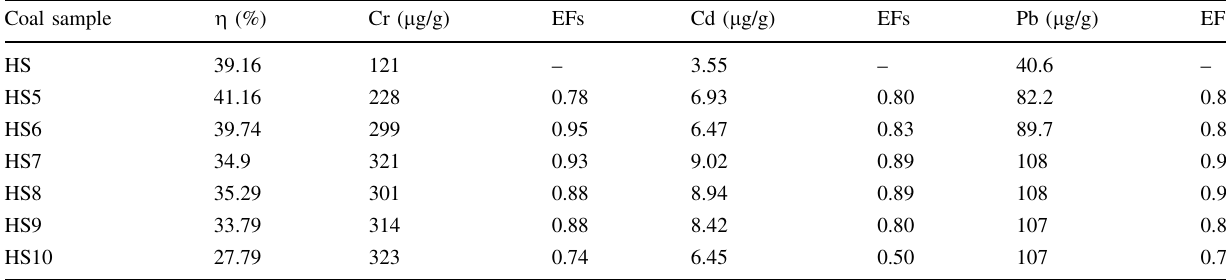
Table 3 Contents and EFs of Cr, Cd, and Pb in raw stone coal and ash samples Coal sample